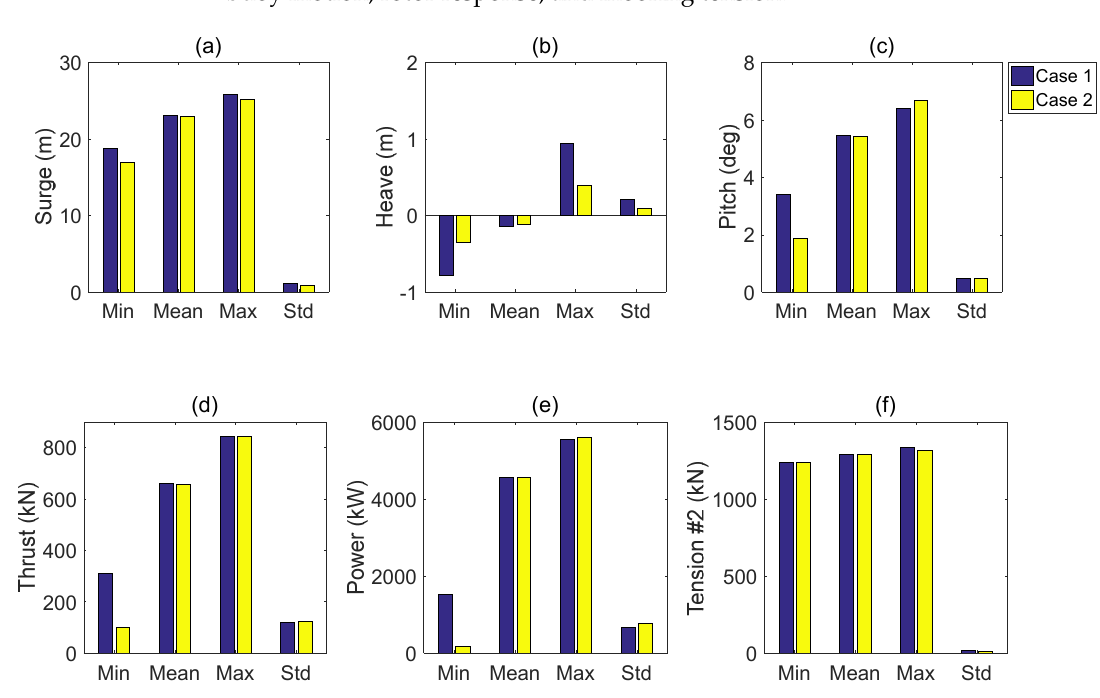
Figure 6. Statistical results of both cases. ( a ) Surge; ( b ) Heave; ( c ) Pitch; ( d ) Thrust; ( e ) Power; ( f ) Tesion#2.